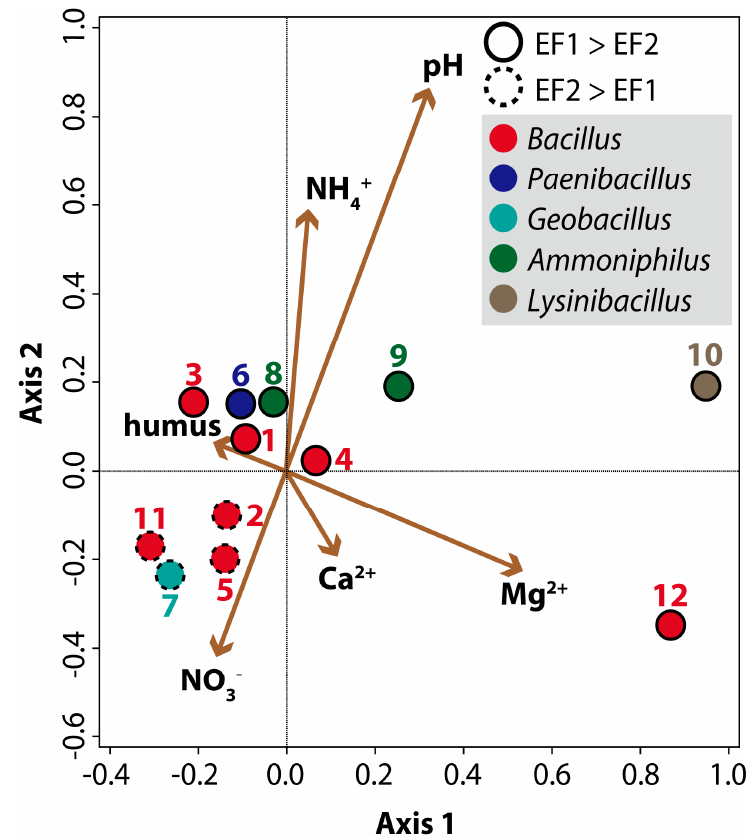
Figure 4. Canonical correlation analysis (CCA) plots based on representative phylotypes 1–12 belonging to order Bacillales and soil chemical parameters during green onion cultivation for 313 days. Solid circles and dashed circles indicate higher abundance rates in EF1 and EF2, respectively. Total variation is 0.22375 and explanatory variables account for 12.7%. Permutation test of all axes showed F = 1.4 and p = 0.022. Explained fitted variation (cumulative %) of Axis 1 and Axis 2 are 35.44% and 60.65%, respectively.